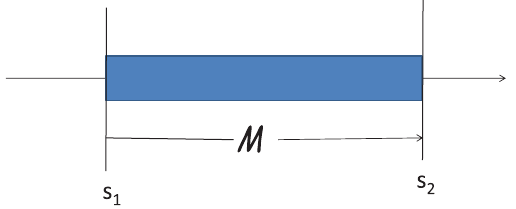
FIG. 4. An element in the beam line represented by its transfer map of the canonical coordinates z ¼ ð x; p x ; y; p y ; δ ; l Þ from position s 1 to s 2 .